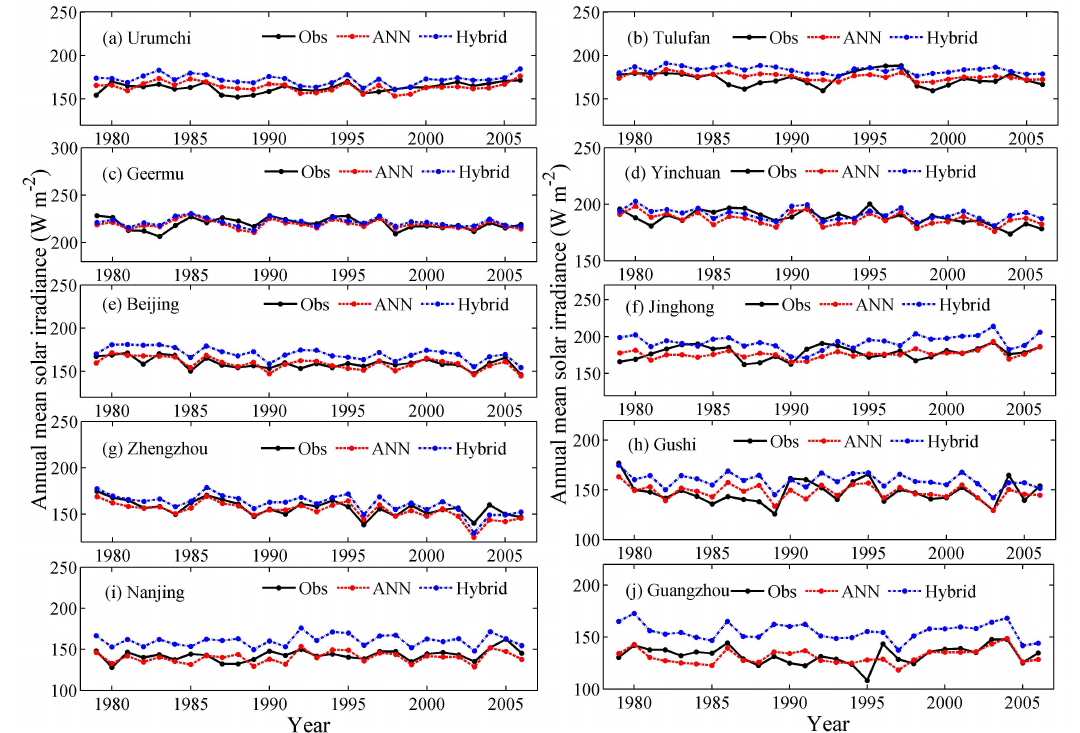
Fig. 2. Comparison of the annual mean solar irradiance time series between 1979 and 2006 among the observed, the estimated by the ANN-based model, and the estimated by the hybrid model at ten radiation stations with “complete records”.